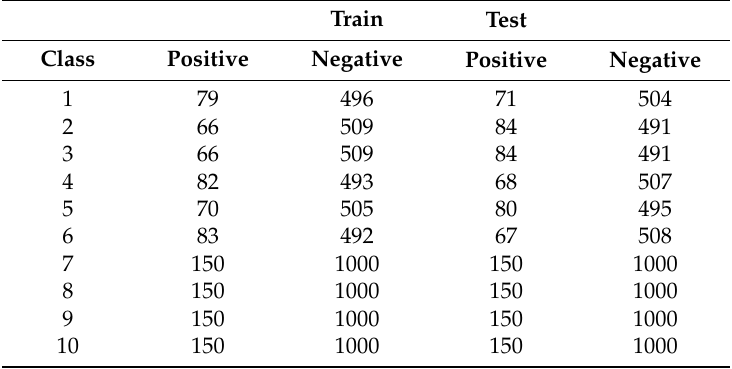
Table 1. Sample distribution of the DAGM dataset.